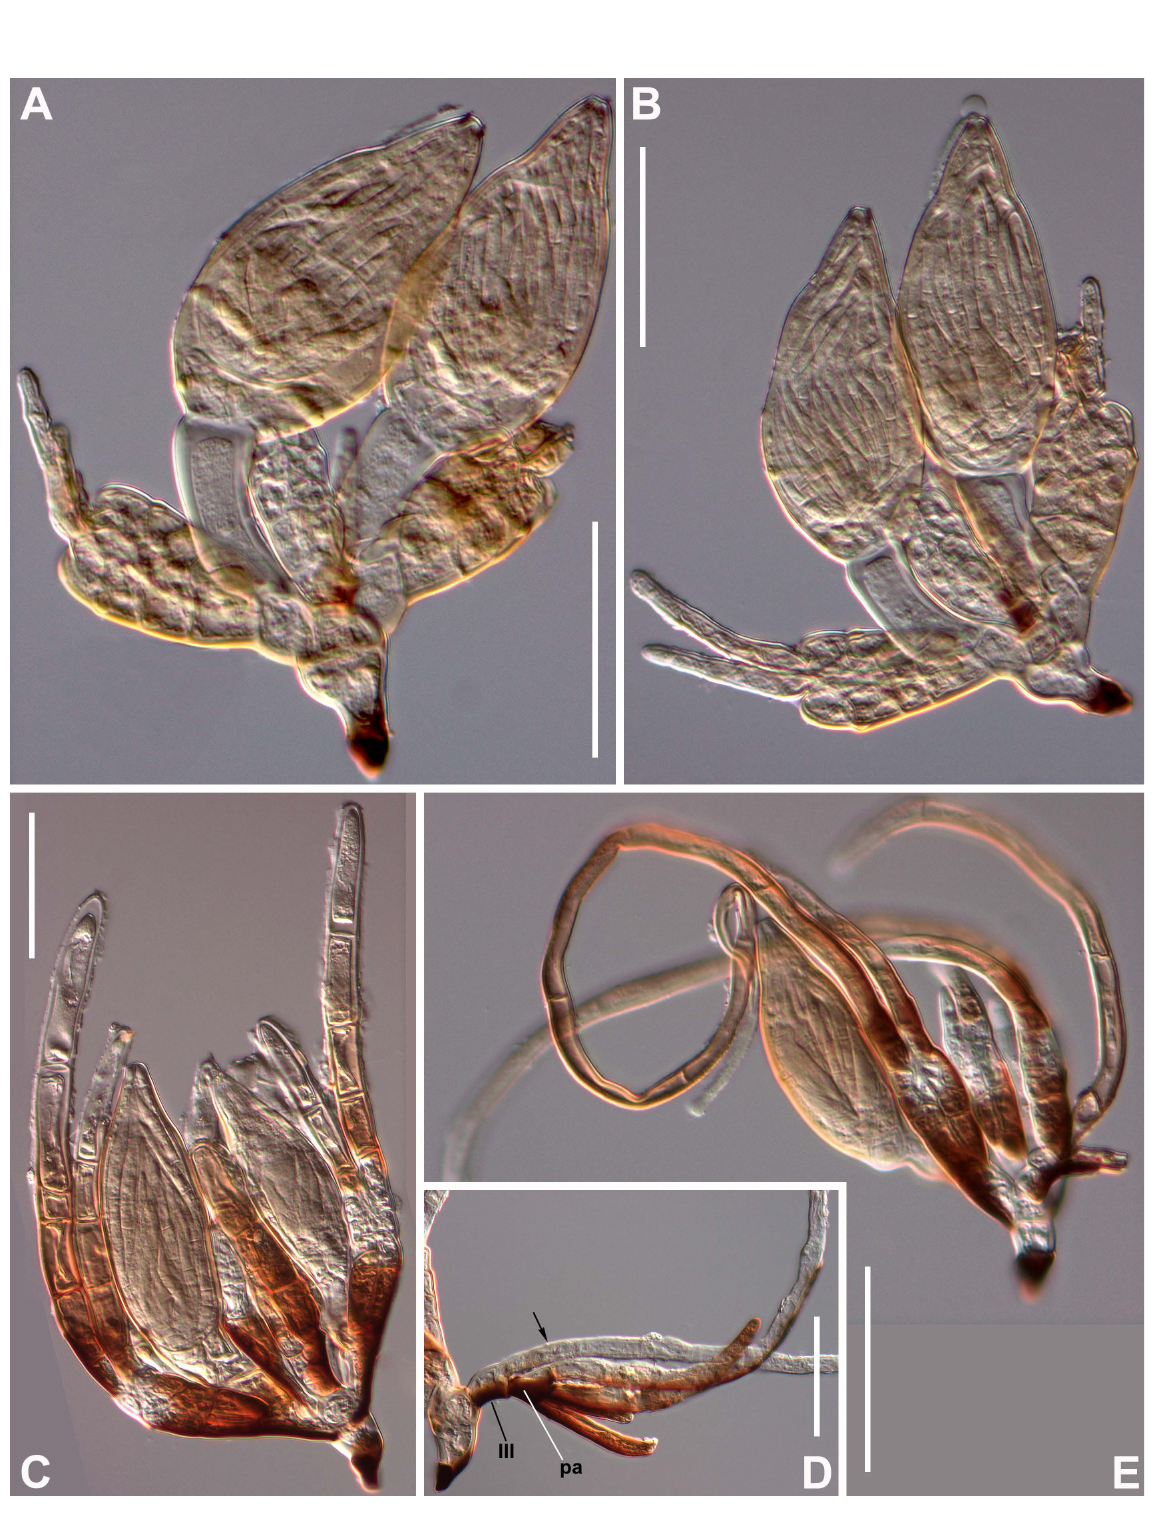
Fig. 85. Monoicomyces spp. A – B . M. drusillae Santam. Mature thalli. – C – E . M. fragilis Scheloske. C , E . Mature thalli. D . Primary appendage (a) and additional branch (arrow) arising from cell III. Scale bars: 50 µm. Photographs from slides ZMUC C-F-123434 (A–B), ZMUC C-F-122963 (C), ZMUC C-F- 123928 (D), ZMUC C-F-123758